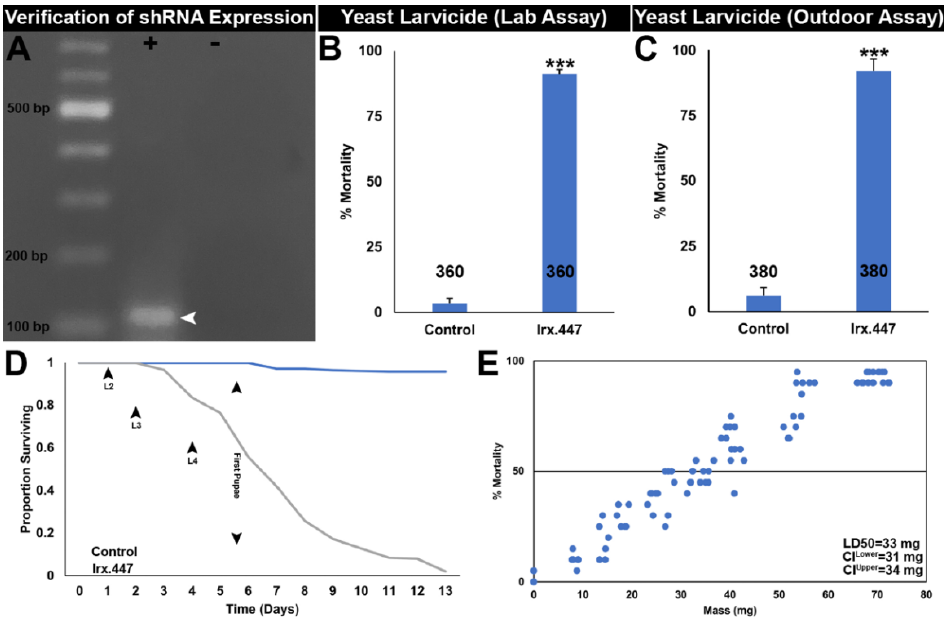
Figure 1. Irx.447 yeast consumption results in A. aegypti larval death. ( A ) A ~100 bp band amplified with primers corresponding to Irx.447 is seen in the lane marked by + in an agarose gel stained with ethidium bromide; cDNA prepared from Irx.447 yeast total RNA was the template in these reactions. No amplicon was detected in a negative control PCR reaction which lacked a cDNA template (marked by a minus symbol). A representative gel from two comparable biological replicate assays is displayed; irrelevant lanes were cropped from the image. ( B ) Consuming Rbfox1.457 yeast throughout larval development caused significant larval death in laboratory insectary trials, as well as in ( C ) semi-field outdoor trials conducted on A. aegypti larvae placed in 7.5 L buckets containing 3.5 L water. In ( B , C ), data combined from multiple replicate trials (each with 20 larvae) are displayed as mean percentages of larval mortality. ( D ) An A. aegypti larval survival curve corresponding to the data in panel ( B ) is shown. ( E ) A dose–response curve illustrates a positive correlation between A. aegypti larval mortality and the amount of Irx.447 yeast contained in larvicide tablets in which control and larvicidal yeast were mixed in varying proportions; each data point in ( E ) corresponds to the percentage mortality found in a single-container assay with 20 larvae; LD 50 values are indicated. In ( B , C ), n numbers are shown under each bar in the graphs, and error bars denote SEMs; *** p < 0.001 (Student’s t -test).